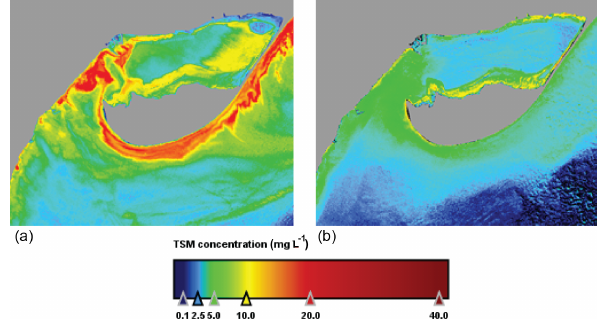
Figure 8. Total suspended matter (TSM in milligrams per litre) ob- tained from Sentinel-2 imagery for Alfacs Bay for two different conditions: northwesterly winds ( a , 27 December 2017) and calm conditions ( b , 15 February